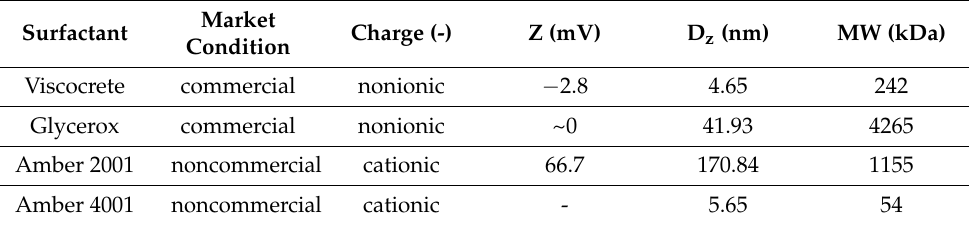
Table 3. Characteristics of surfactants